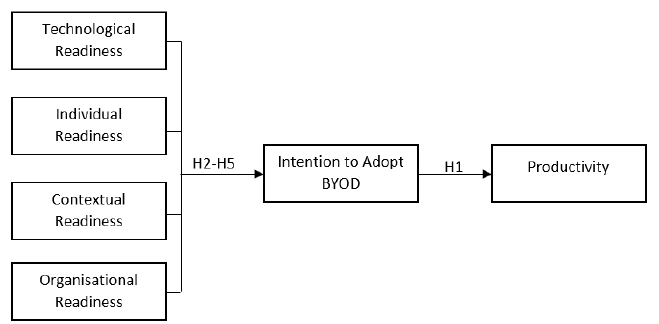
Figure 1. Conceptual Framework